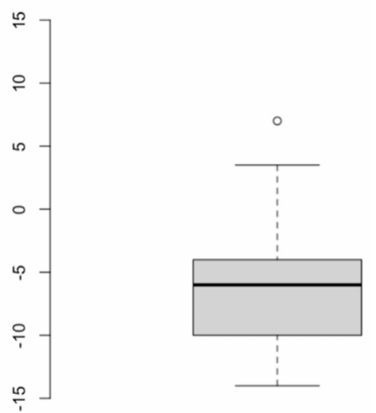
Figure 1. Score distribution of analysed children